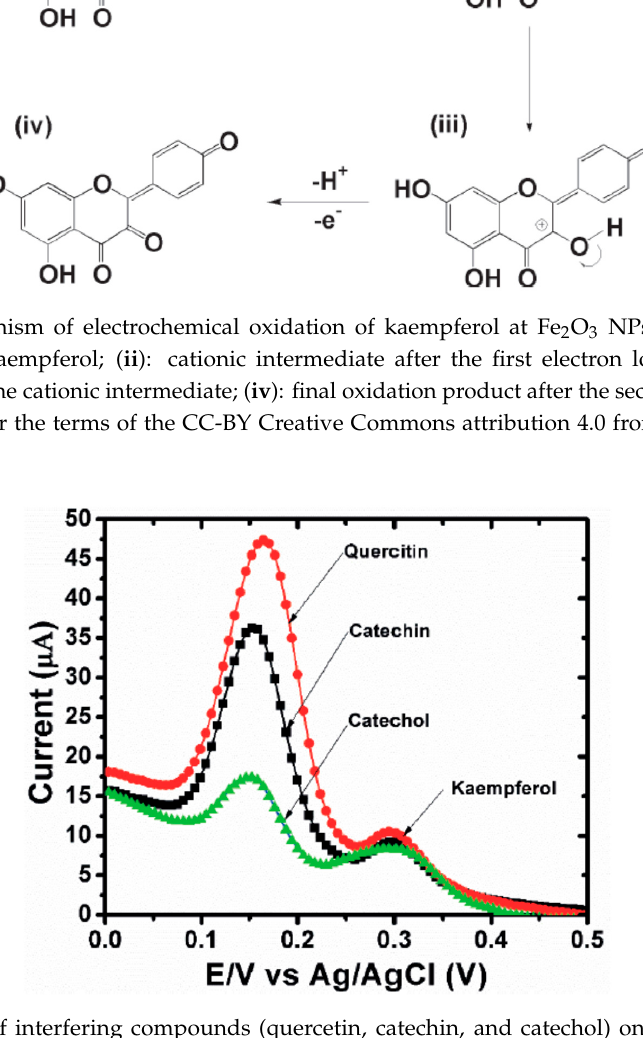
Figure 6. Effect of interfering compounds (quercetin, catechin, and catechol) on the detection of kaempferol under the optimum conditions. Reproduced under the terms of the CC-BY Creative Commons attribution 4.0 from Reference [54], Copyright 2019.